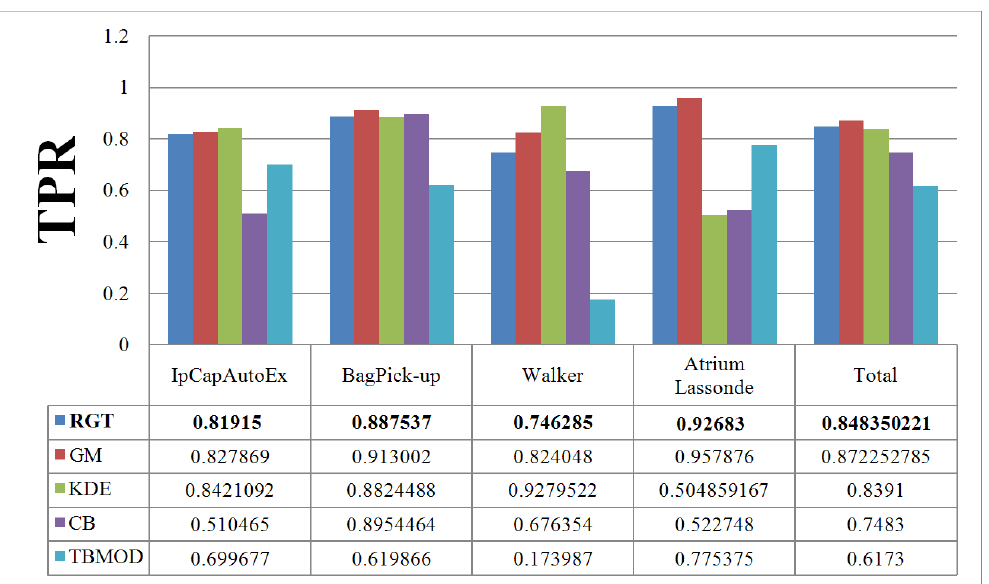
Figure 10. True Positive Rate of different variations of the proposed background subtraction method for our dataset. The Total column is the combination of all the videos. RGT: our method, GM: Gaussian Mixture, KDE: Kernel Density Estimation, CB: CodeBook, TBMOD: Texture-based Moving Object